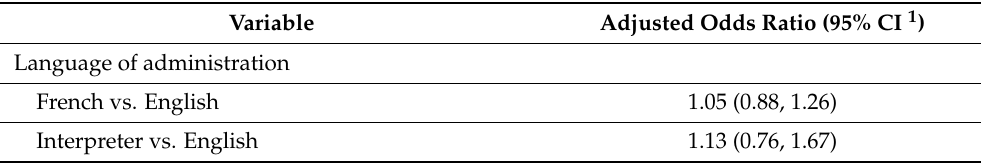
Table 6. Factors affecting odds of Bayley-III Language Composite Scores < 85—by language of administration (multivariate